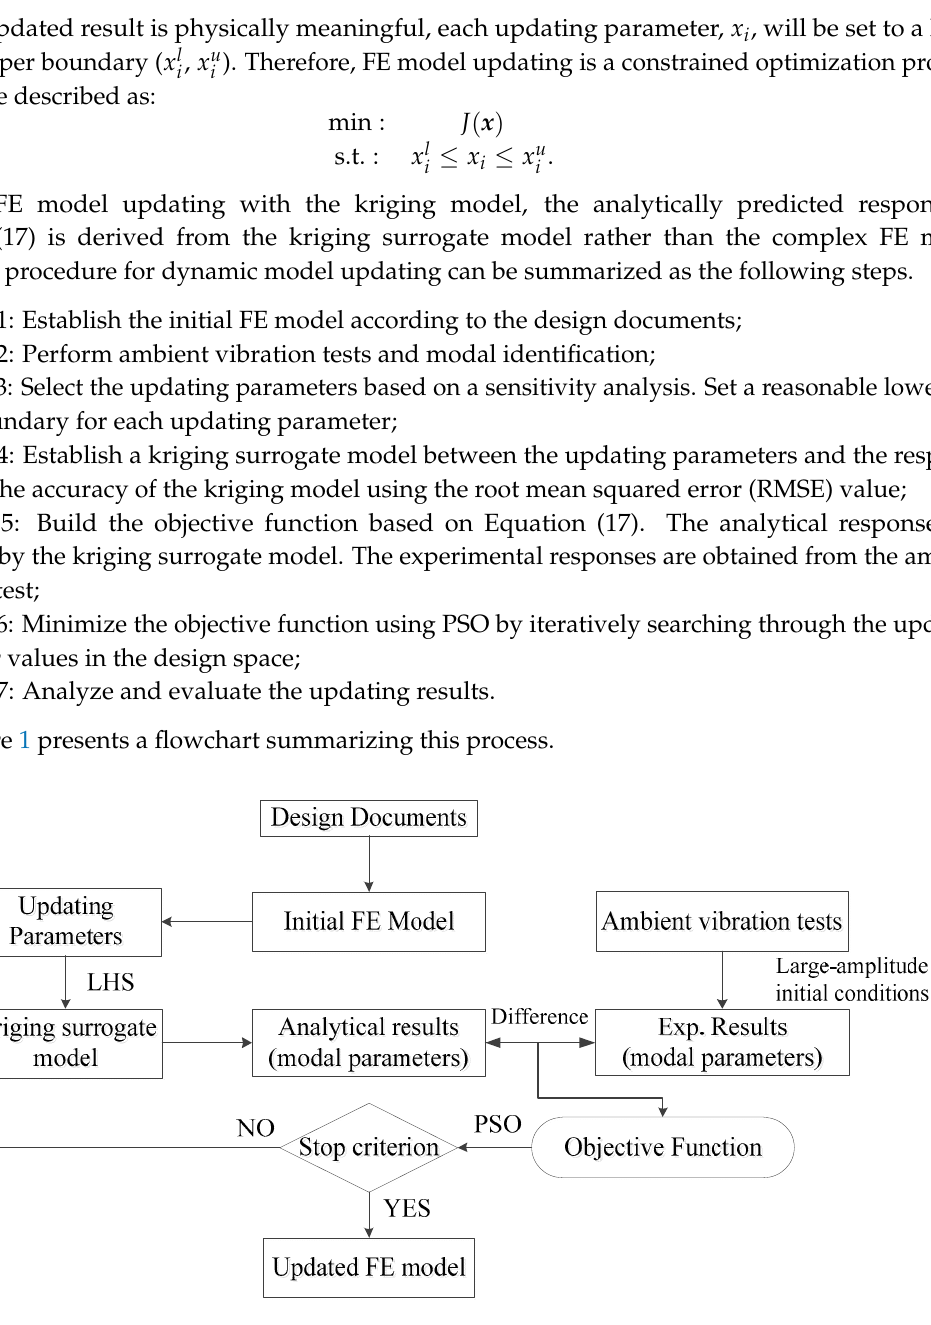
Figure 1. Flow chart of the finite element (FE) model updating with kriging model.